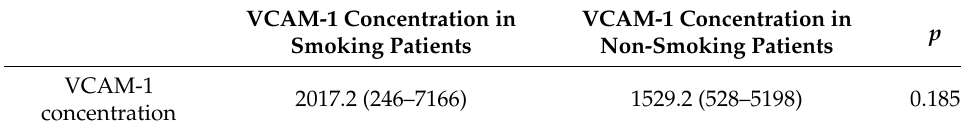
Table 7. The statistical significance of smoking and VCAM-1